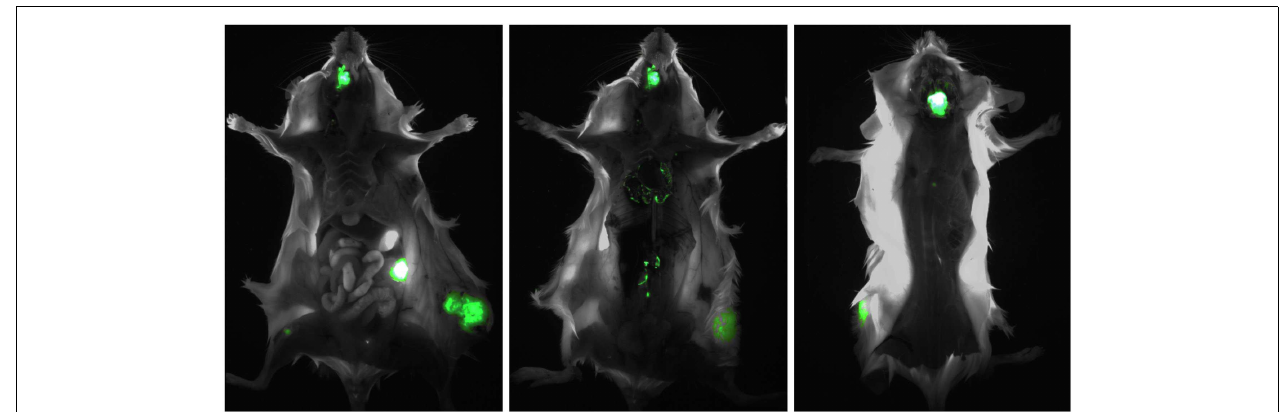
( center panel ), the paravertebral lymph nodes ( center panel ), and the brain ( right panel ). Left panel , ventral view; center panel , ventral view after removal of the rib cage and abdominal viscera; left panel, dorsal view after partial removal of the brain, to reveal a large underlying metastasis.